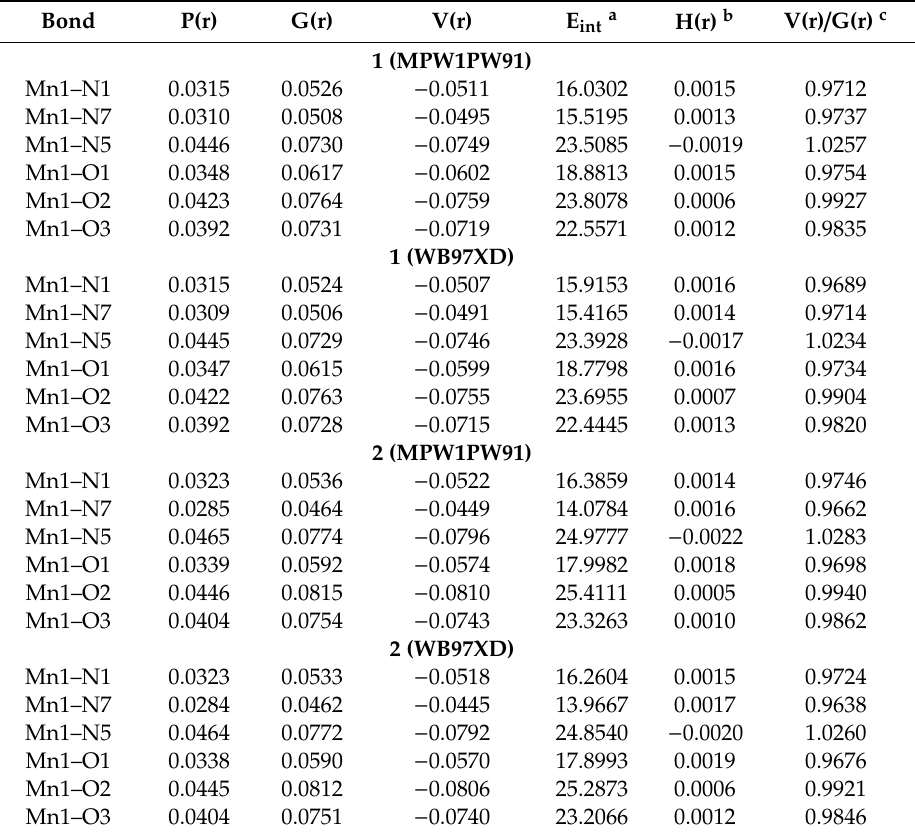
Table 5. Atoms in molecules (AIM) indices (a.u.) for the Mn–O and Mn–N bonds.